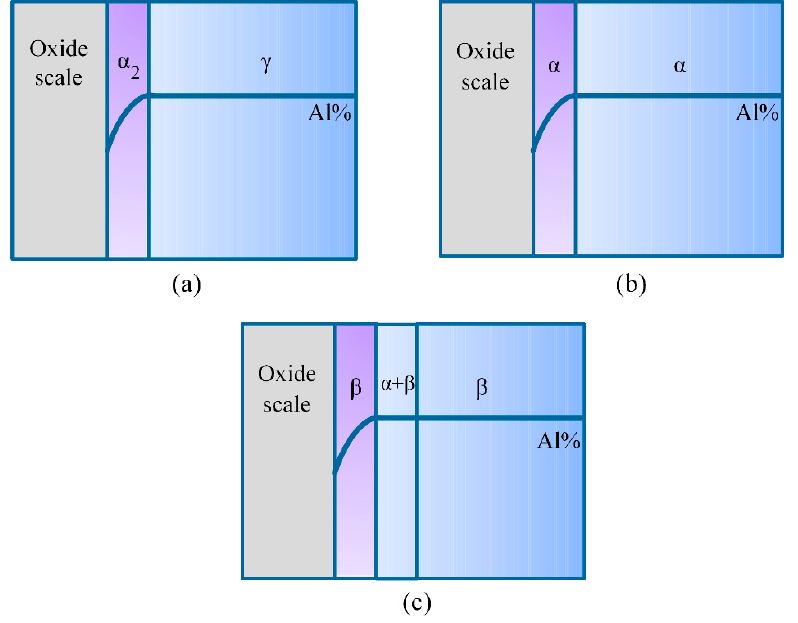
Figure 15. Schematic diagrams of the phase structures for ( a ) the Ti-46Al-2Cr-5Nb alloy when T < T < 1280 ◦ C, ( b ) the Ti-46Al-2Cr-5Nb alloy when T > 1280 ◦ C and ( c ) the Ti-24Al-15Nb-1.5Mo alloy at 1280 °C, ( b ) the Ti-46Al-2Cr-5Nb alloy when T > 1280 °C and ( c ) the Ti-24Al-15Nb-1.5Mo alloy at the the temperature range of 1280–1350 ◦ temperature range of 1280–1350 °C.